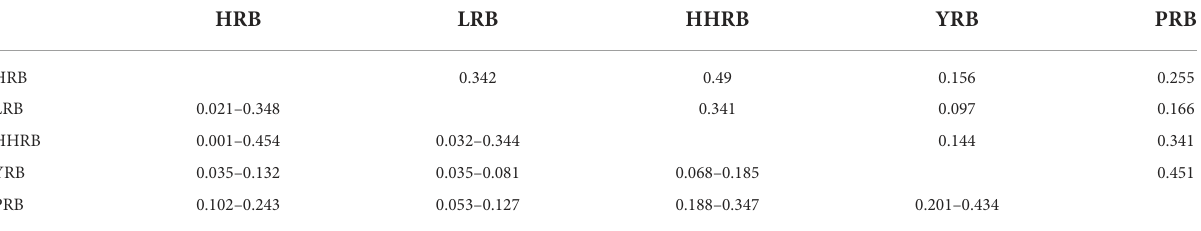
TABLE 9 Background similarity test between genetic clusters with all comparisons being significant at 95 CI level. HRB